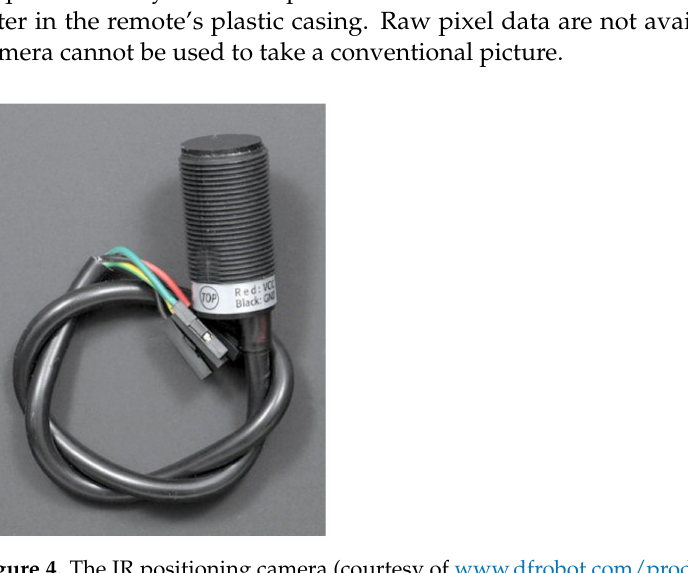
Figure 4. The IR positioning camera (courtesy of www.dfrobot.com/product-1088.html, accessed on